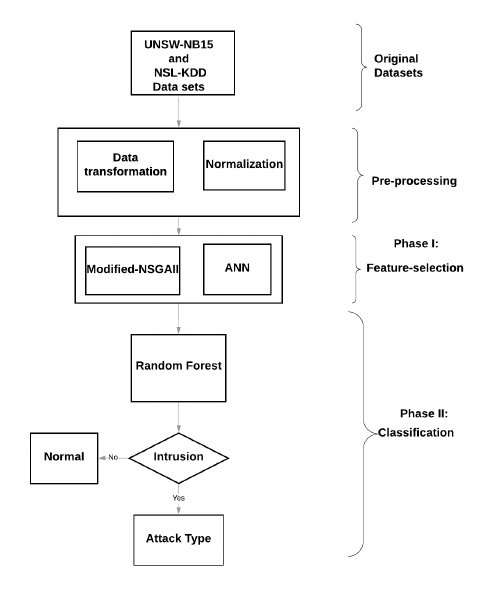
Figure 1. Proposed